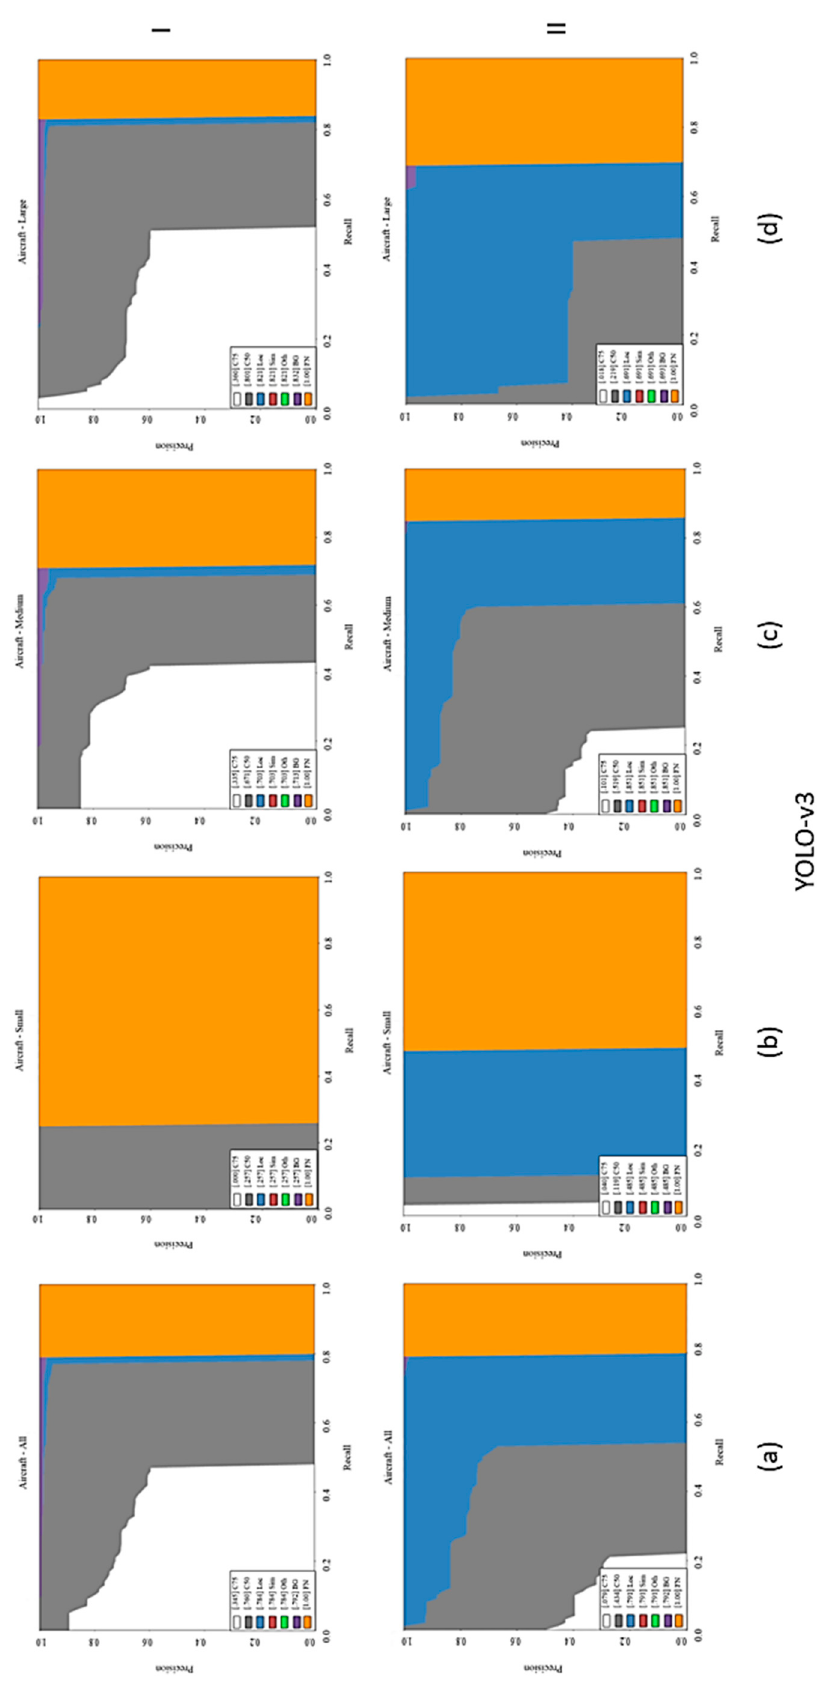
Figure A2. YOLO—V3 Precision–recall curves for, ( a ) all object sizes, ( b ) small, ( c ) medium, ( d ) large object size obtained from, (I) DOTA test data and (II) Pleiades large-scale test image data.